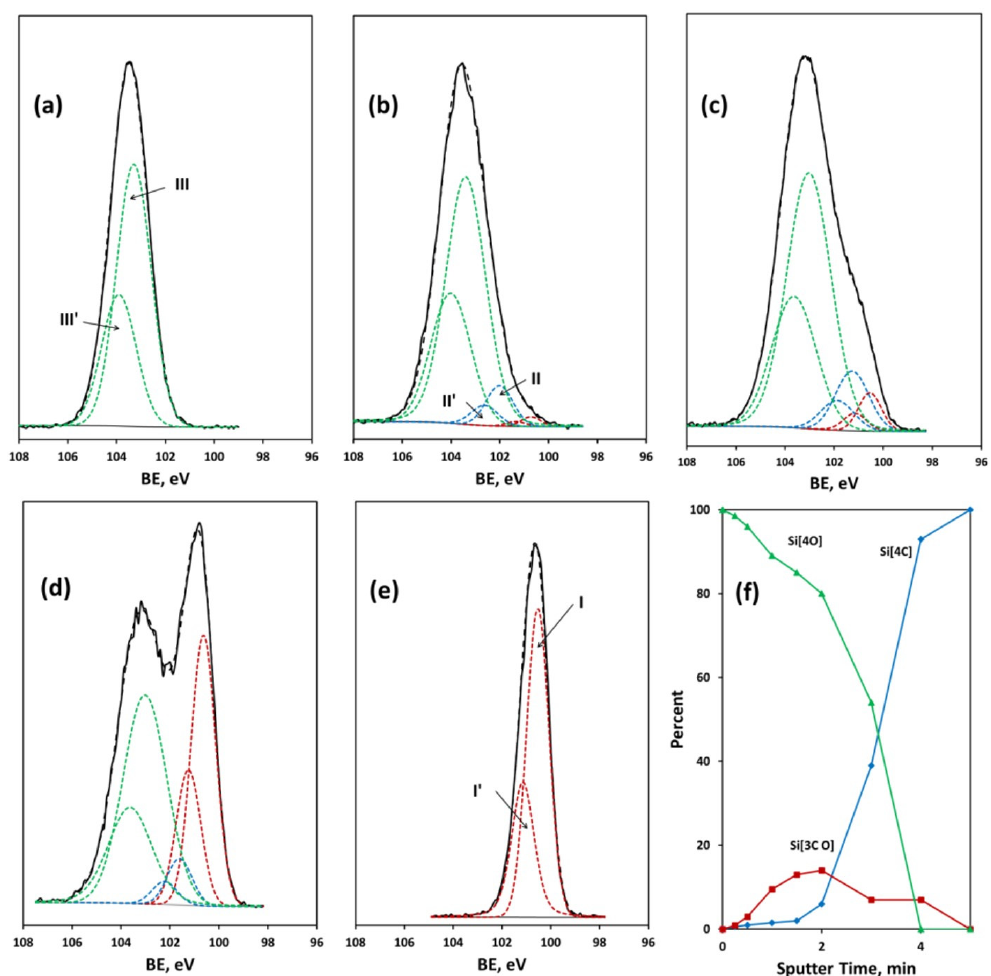
Figure 4. Si 2p region of a 30A sample ( a ) before sputtering and ( b – e ) after 1 min, 2 min, 3 min, and 5 min sputtering. Experimental curves—black solid lines; composite curves—black dashed lines; fitted doublet I-I’ at 100.4 eV assigned to Si[4C] component—red dashed lines; fitted doublet II-II’ at 101.8 eV assigned to Si[3C O] component–blue dashed lines and fitted doublet III-III’ at 103.3 eV assigned to Si[4O] component—green dashed lines. ( f ) Variation in the Si 2p components as a function of 10 keV Ar 2500+ sputter time.